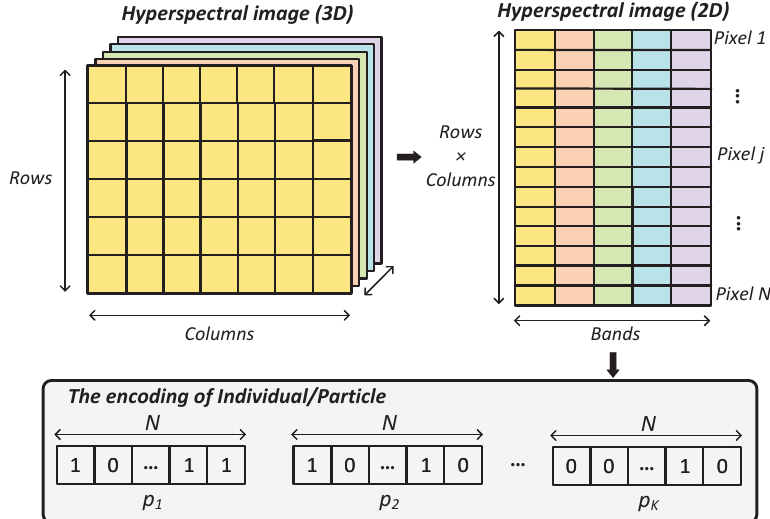
Figure 1. The initialization mechanism of the individuals or